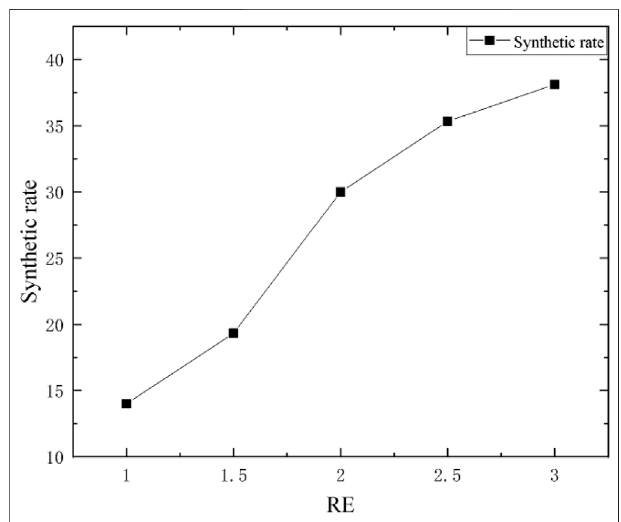
FIGURE 3 | Effect of different ethanol dosage on synthesis rate of